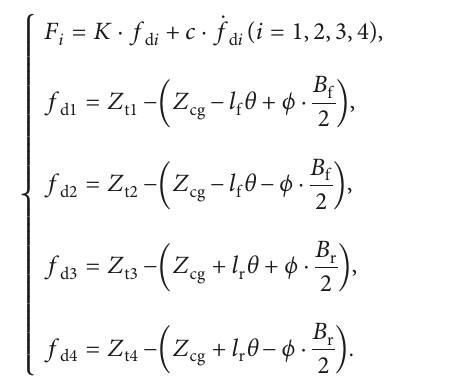
Figure 1: A physical model of vehicle body and wheels for vertical vibration. Table 2: Parameters for the full car